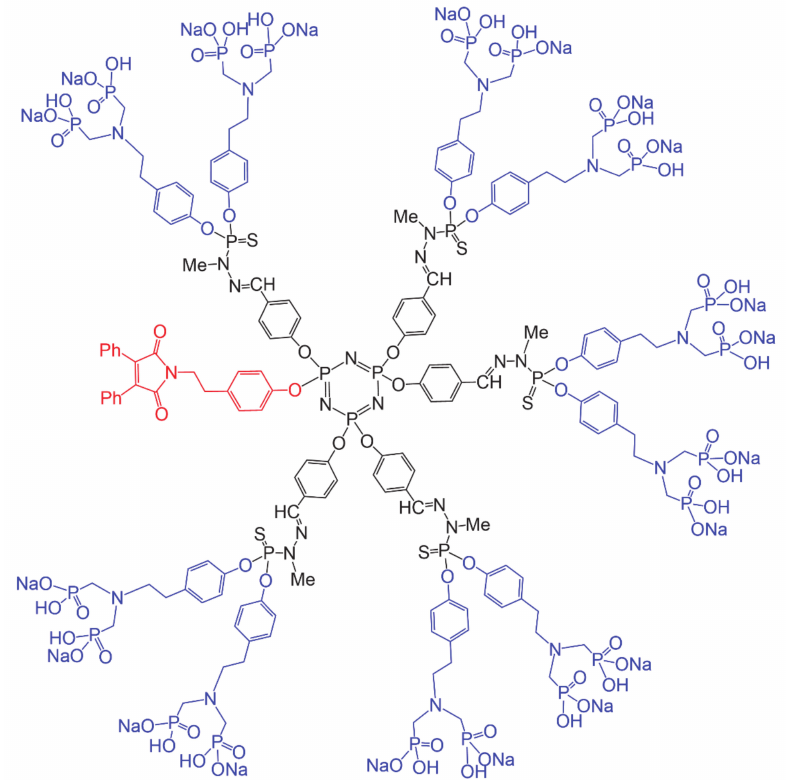
Figure 7. Full chemical structure of a first generation dendron having a maleimide at the core and 10 azabisphosphonate terminal